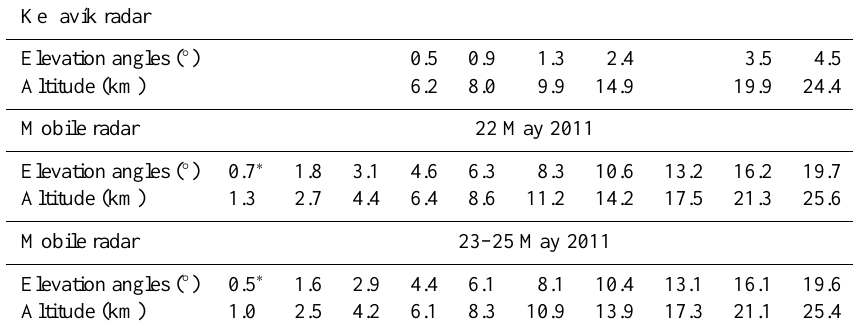
Table 2. Elevation angles and altitudes (kma.s.l.) of the radar-beam midpoints at the lowest levels over Grímsvötn volcano. Keflavík radar